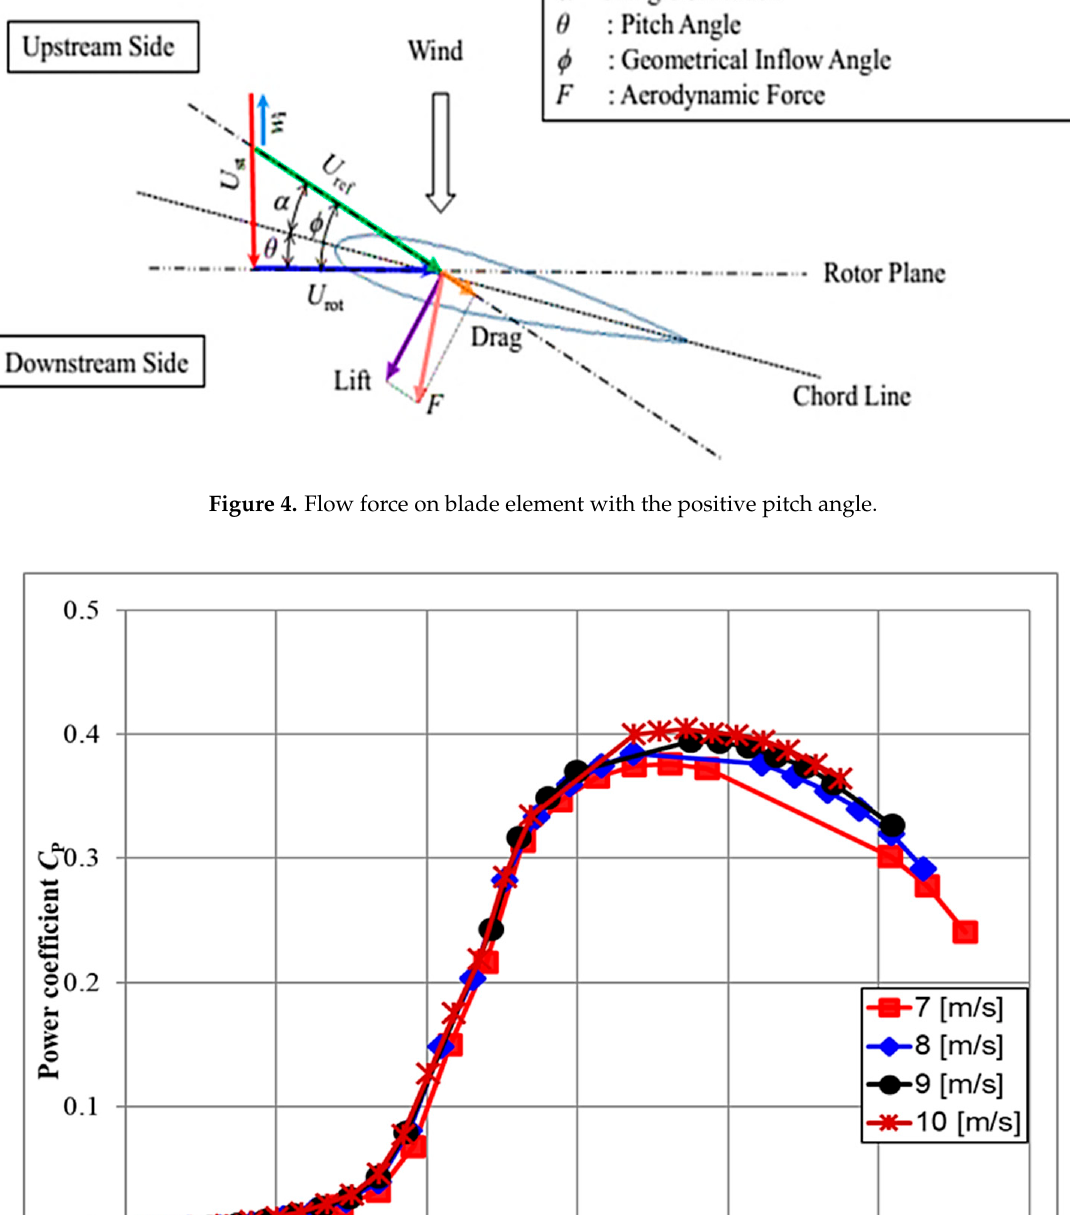
tip speed ratio λ increases to reach the maximum value and then decreases. The angle of attack increases in the low tip speed ratio region. As a result, the blade has an excessive angle of attack, the lift force decreases, the drag force increases, and the power